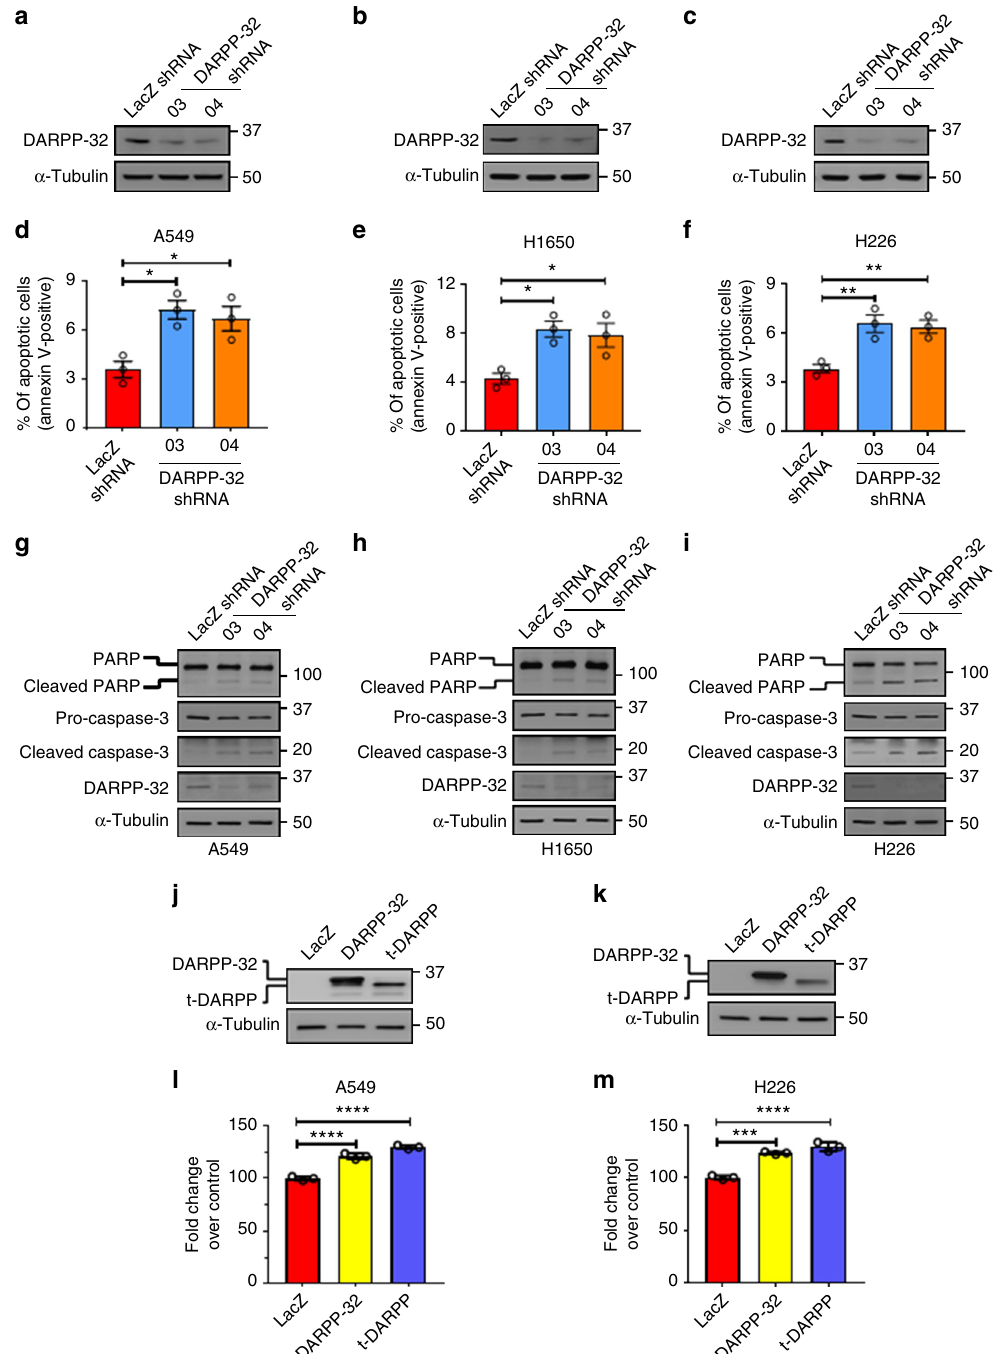
Fig. 1 DARPP-32 promotes cell survival and negatively regulates apoptosis. a NSCLC A549, b H1650 and c H226 cell lines were transduced with lentivirus encoding LacZ control shRNA or DARPP-32 shRNAs (clone numbers 03 and 04). DARPP-32 and α -tubulin (loading control) proteins were detected by immunoblotting of cell lysates. Immunoblots are representative of three independent experiments. d A549, e H1650 and f H226 cells transduced with control or DARPP-32 shRNAs were seeded into 60 mm culture dishes for 16 h. Flow cytometry-based apoptosis assays were performed following incubation with anti-annexin V antibodies conjugated with APC. g A549, h H1650 and i H226 cells were transduced with control or DARPP-32 shRNAs and immunoblotted with antibodies to detect cleaved and uncleaved PARP, cleaved and uncleaved (i.e., pro-) caspase-3, DARPP-32 and α -tubulin (loading control). j A549 and k H226 cells were transduced with retrovirus containing control (LacZ), DARPP-32- or t-DARPP-overexpressing clones. DARPP-32, t- DARPP and α -tubulin (loading control) proteins were detected by immunoblotting of cell lysates. Immunoblots are representative of three independent experiments. l A549 and m H226 cells transduced with control, DARPP-32- or t-DARPP-overexpressing clones were seeded into 96-well cell culture plates for 72 h. Colorimeter-based cell survival assay was conducted using MTS reagents. Each open circle on a graph represents an independent experiment. Uncropped images of depicted immunoblots are shown in Supplementary Figs. 13-15. Error bars indicate SEM ( n = 3). * P < 0.05, ** P < 0.01, *** P < 0.001 and **** P < 0.0001, one-way ANOVA followed by Dunnett ’ s test for multiple